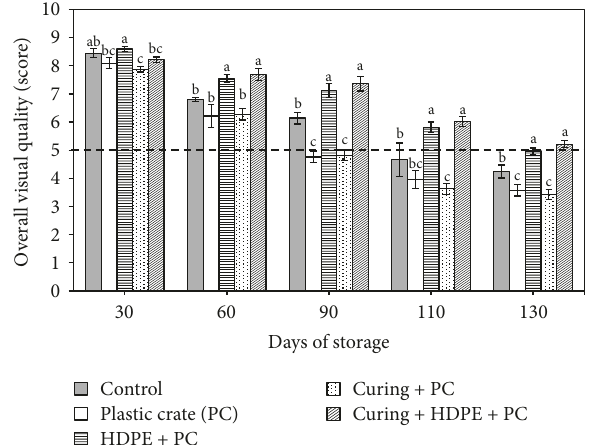
Figure 7: Overall visual quality score of radish roots during storage at low temperature under different packaging treatments. Vertical bars represent ± SE of mean. For each evaluation day, different letters indicate significant differences ( 𝑃 < 0.05 ) among